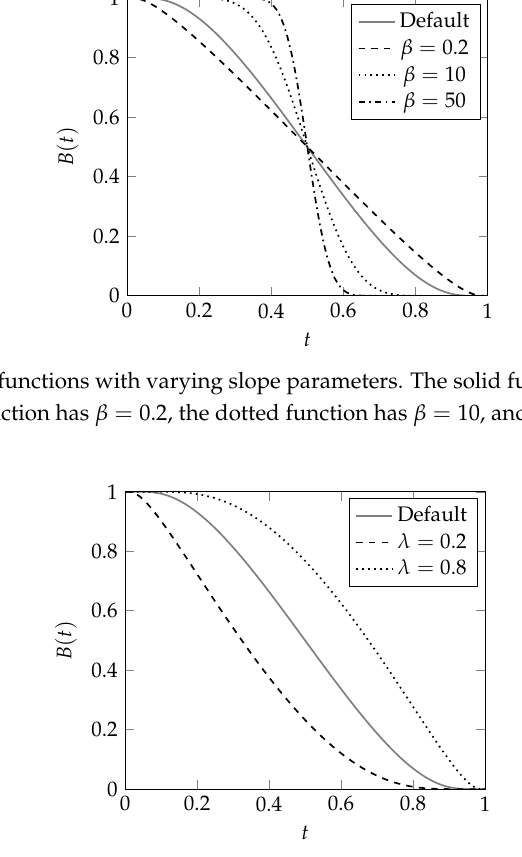
Figure 9. Plots of ERB-functions with Figure 10. Plots of ERB-functions with Figure 10. Plots of ERB-functions with varying balance parameters. The solid function is the default varying slope parameters. The solid varying balance parameters. The solid ERB ( λ = 0.5), the dashed function has λ = 0.2, and the dotted function has λ = function is the default ERB ( β = 1), the function is the default ERB ( λ = 0.5), the dashed function has β = 0.2, the dotted dashed function has λ = 0.2, and the dotted function has β = 10, and the dashdotted function has λ = 0.8. function has β = 50.